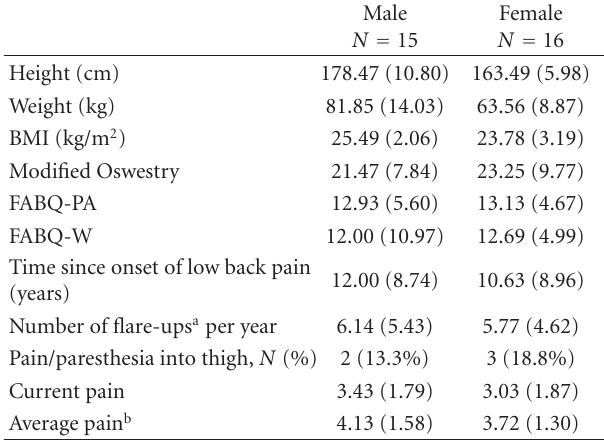
Table 1: Means (standard deviations) for subject